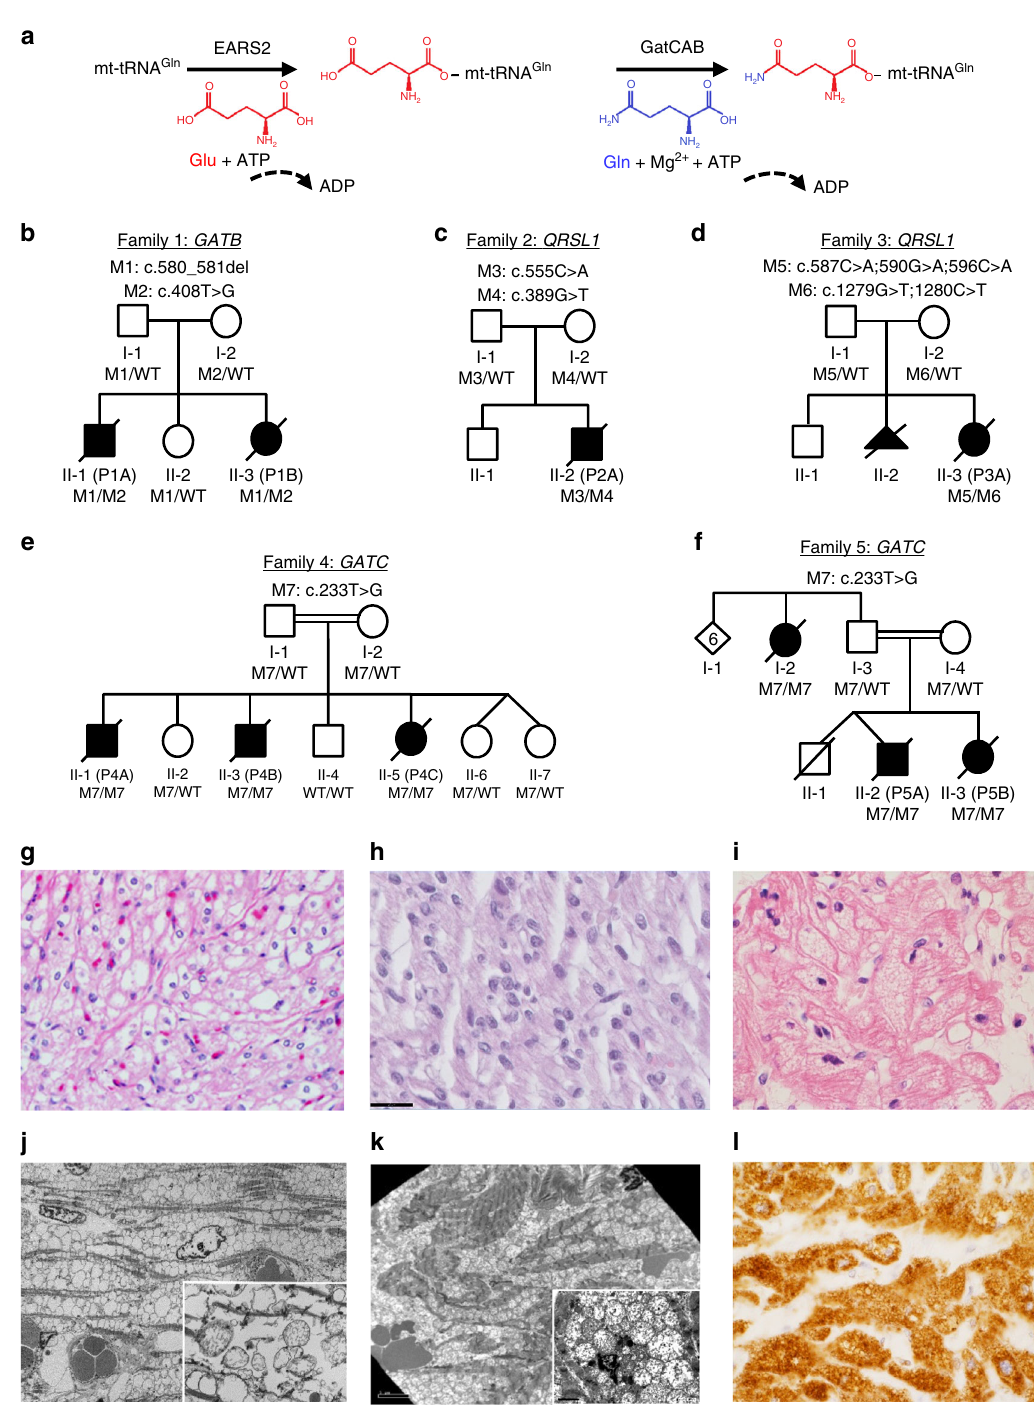
Fig. 1 Pathogenic variants in GatCAB subunits lead to a lethal metabolic cardiomyopathy. a Mitochondrial-tRNA Gln is charged with glutamine in a two-step reaction. b – f Pedigrees of the families with pathogenic variants in QRSL1 , GATB , or GATC as identi fi ed in the patients. g – l Pathology of patients' heart tissues. g – i Light microscopy on hematoxylin-eosin staining showed pericardial clearing in patients g P3A (GatA, magni fi cation 100X), h P1A (GatB, magni fi cation 100X (scale bar 20 μ m), and i P4A (GatC, magni fi cation 100X). j , k Electron microscopy of the heart showed extensive mitochondrial proliferation displacing the contractile elements in patients j P3A (GatA, magni fi cation 2700X, insert magni fi cation 27,000X) and k P4A ( GatC, magni fi cation 2500X (scale bar 5 μ m), insert magni fi cation 12,000X (scale bar 2 μ m). l SDHB immunostaining in patient P4A (GatC) showed massive increase in mitochondria in the heart (magni fi cation